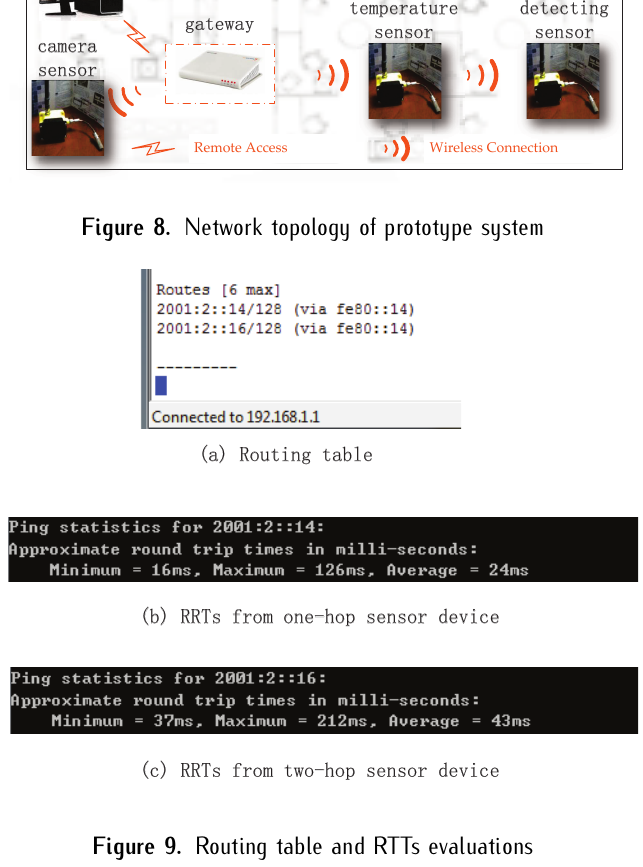
Figure 9. Routing table and RTTs evaluations